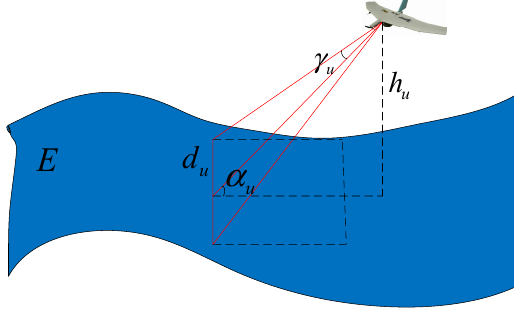
Figure 1. Airborne sensor detection model.